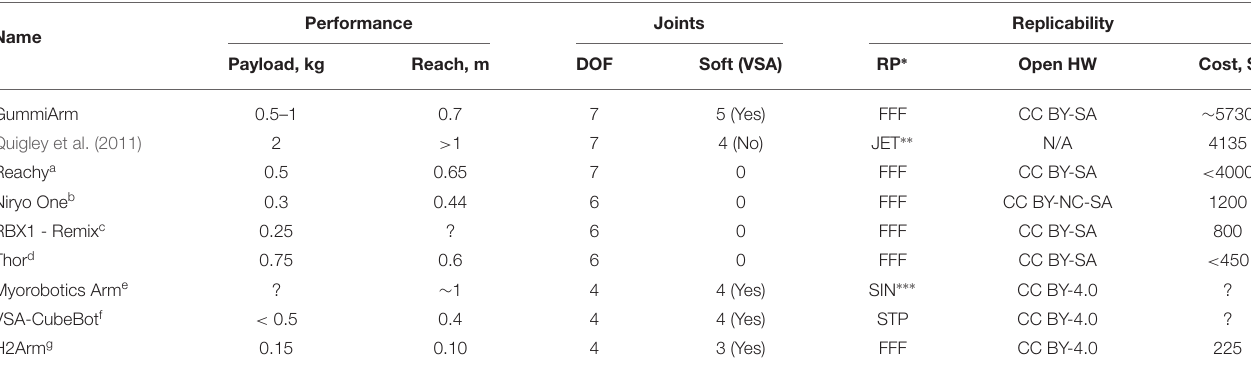
TABLE 1 | Comparison of a set of currently available replicable robot